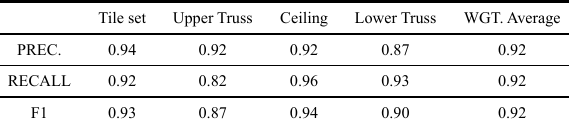
Table 4. Classification metrics at level 2 for